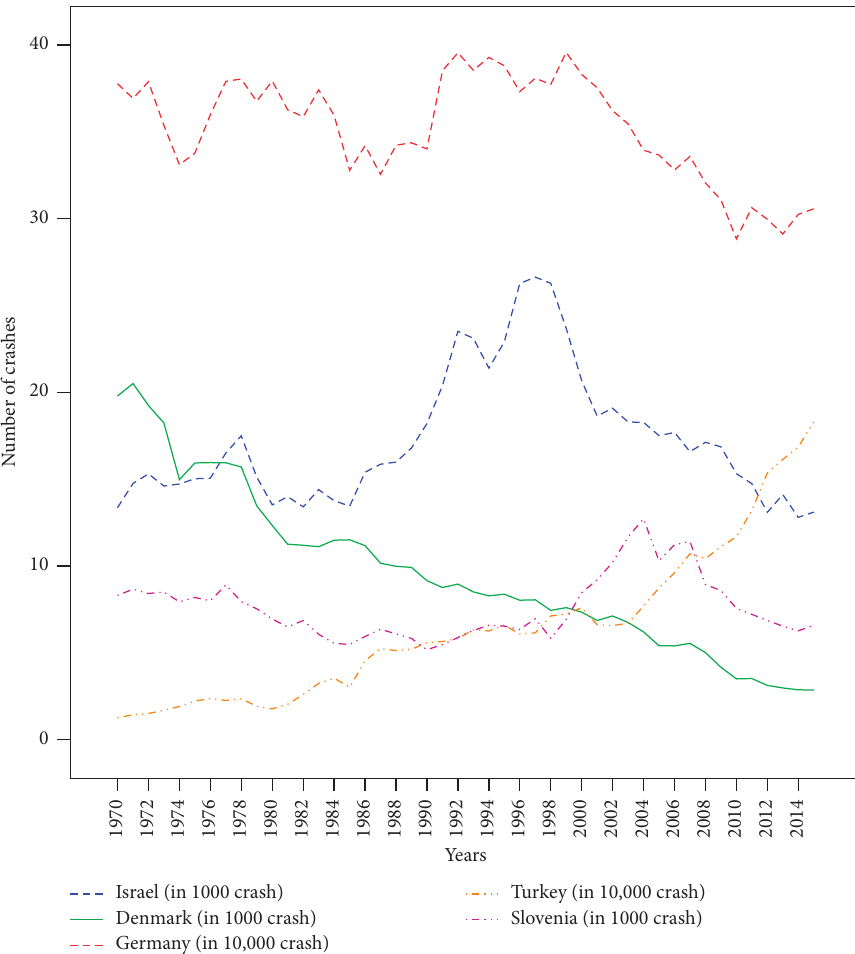
Figure 1: Trends of road crashes for the studied countries (1971–2015). Table 2: Prediction models based on different sample sizes (number of